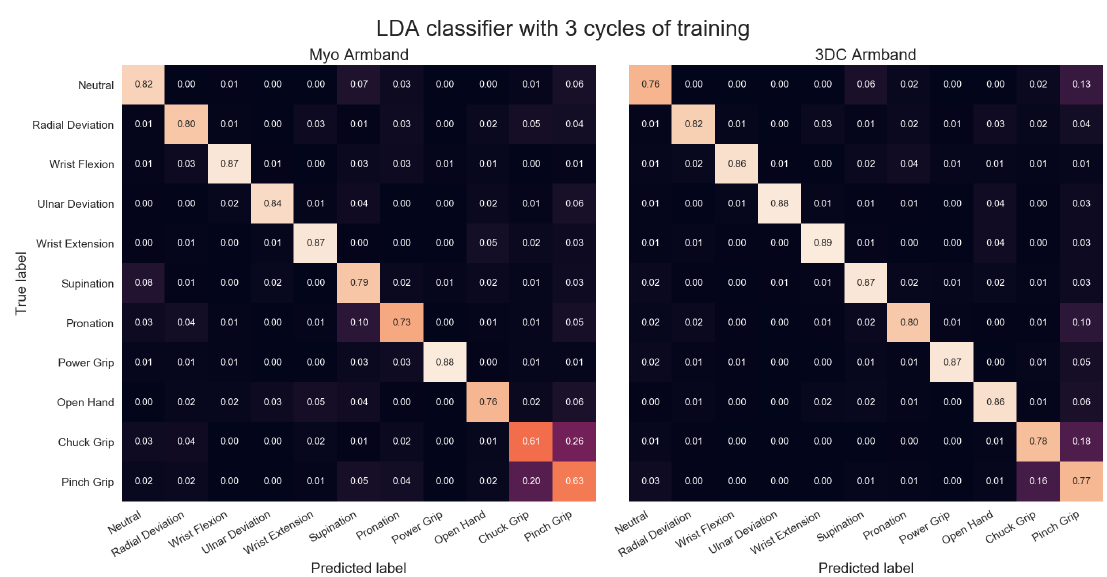
Figure A3. Confusion Matrices for the Myo and the 3DC Armband employing LDA for classification and three cycles of training. Lighter is better.